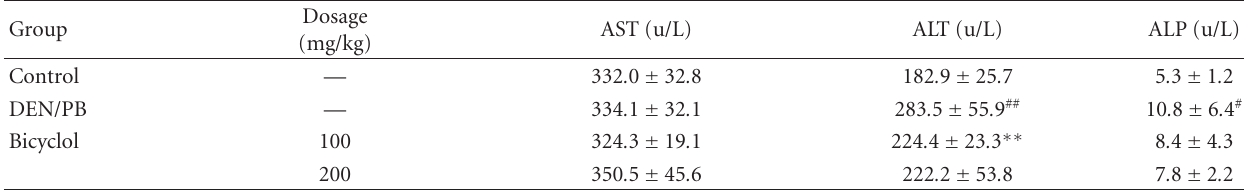
Table 2: Levels of serum marker enzymes ALT, AST, and ALP in all groups.